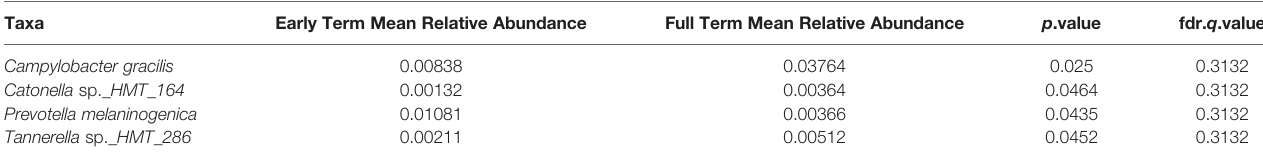
TABLE 5 | Four taxa identi fi ed in late pregnancy to have signi fi cantly different relative abundances between spontaneous early term and full term births.